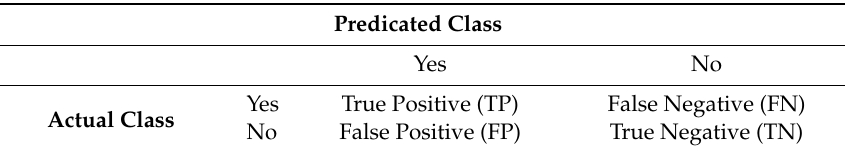
Table 4. Confusion Table 4. Confusion matrix.